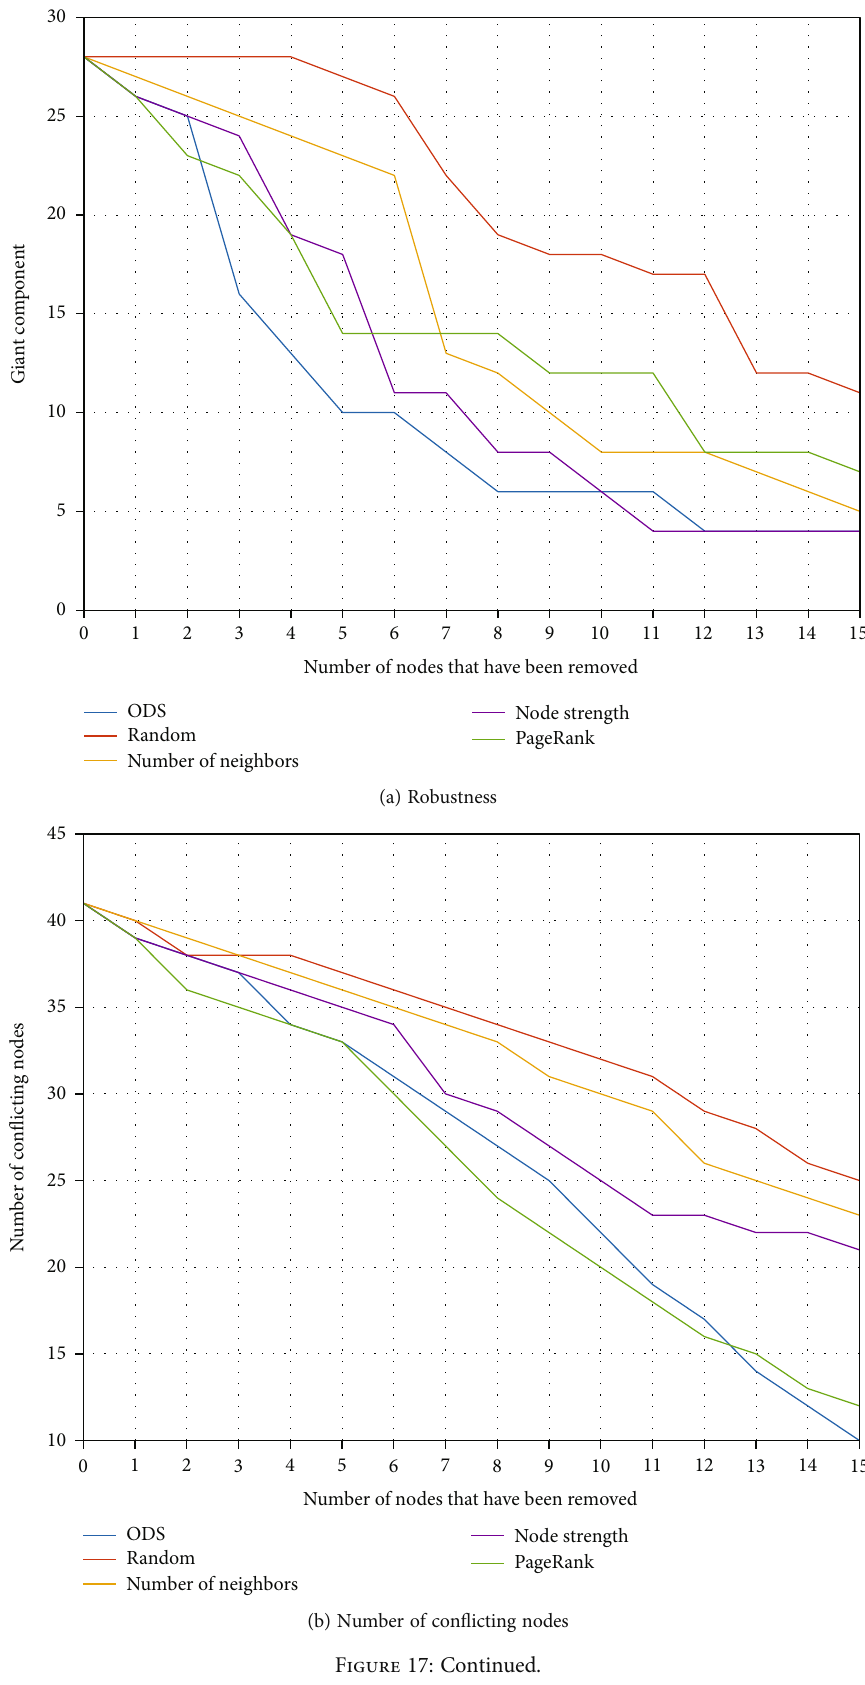
(b) Number of con fl icting